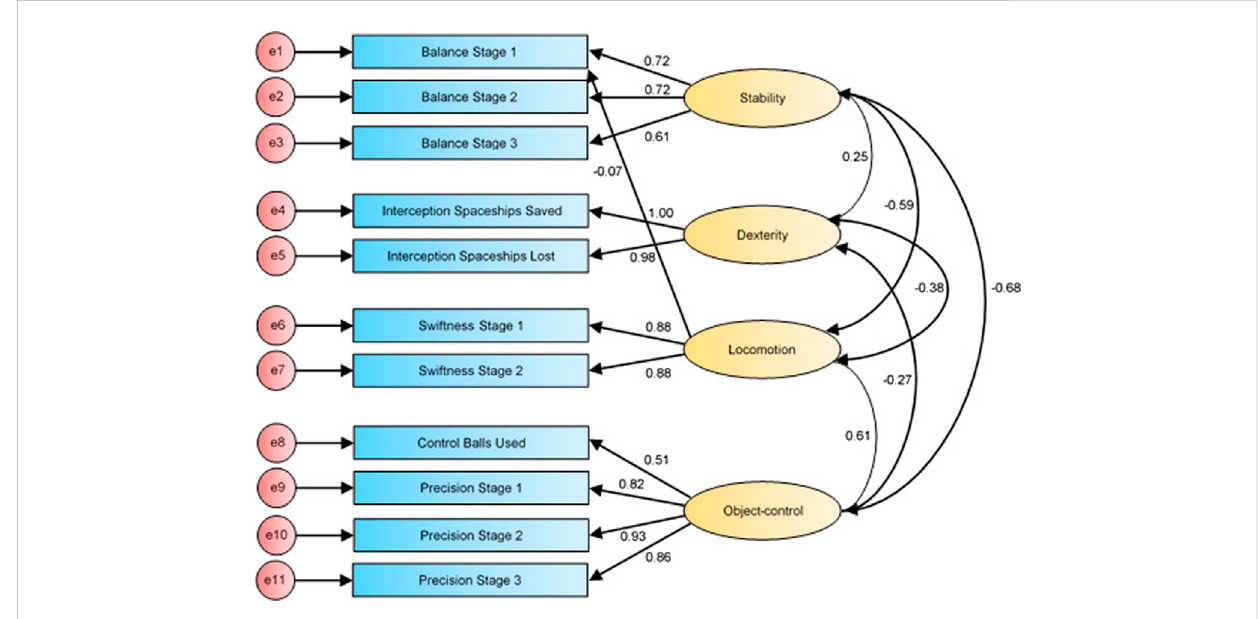
FIGURE 1 First-order factor structure of the GMCA (initial fi t; Model 1).